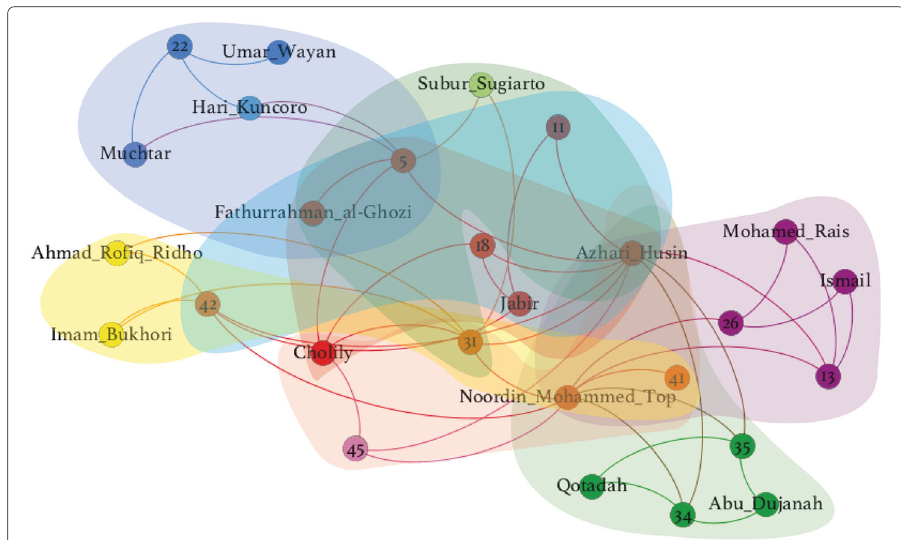
Sungkar and Agus Ahmad . Apuy overlaps in almost strong community 2 and weak com- munity 3, reflecting the common Training category he attended with the members from both communities. The actors with the most community memberships are the three who together form weak community 2: Iqbal Huseini, Azhari Husin and Noordin Top with 12, 11 and 10 memberships respectively. This indicates that they are important nodes in the network. In term of core and peripheral nodes, using the formulas (11) and (12) we have μ ≈ 2.38 and σ ≈ 2.32, and on selecting t p = 1 (to isolate nodes with membership 1), and t c = 1 for consistency, we have μ + σ = 4.7 and μ − σ = 0.06. Therefore, the core nodes are those with membership 5 or more and peripheral nodes are those with membership